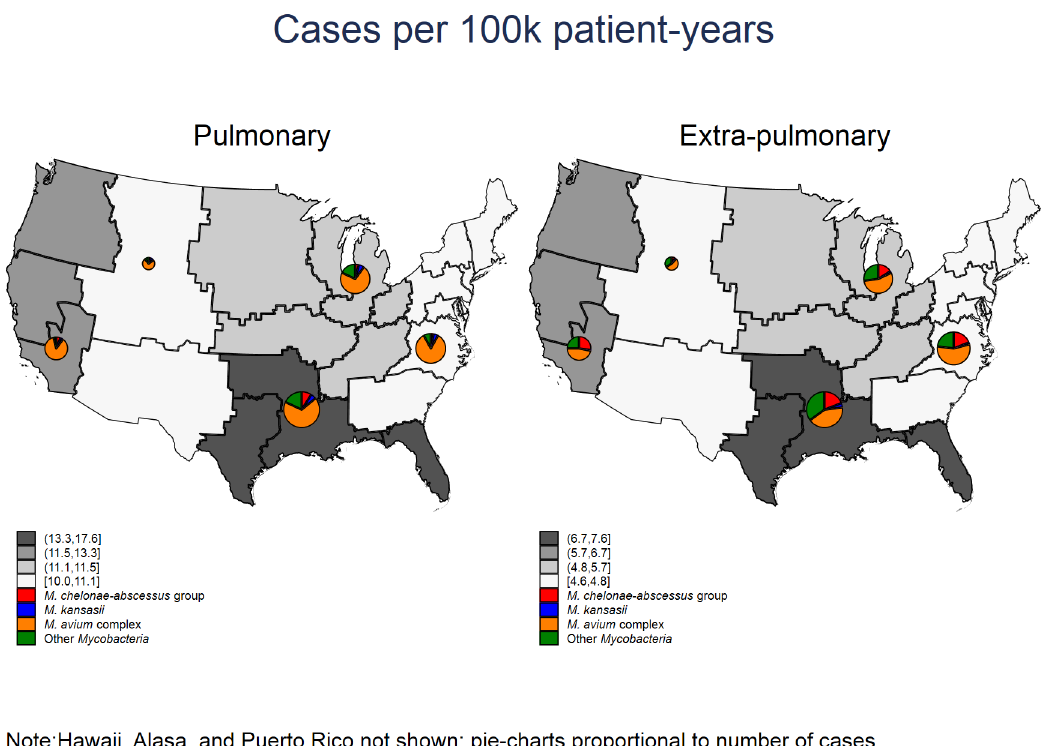
Fig 1. Incident rates of NTM cases per 100,000 patient-years by region and by microbiologically-identified organism from 2009 through 2012. Reprinted from Esri 1 ArcGIS Online 1 under a CC BY license, with permission from Environmental Systems Research Institute, Inc., original copyright